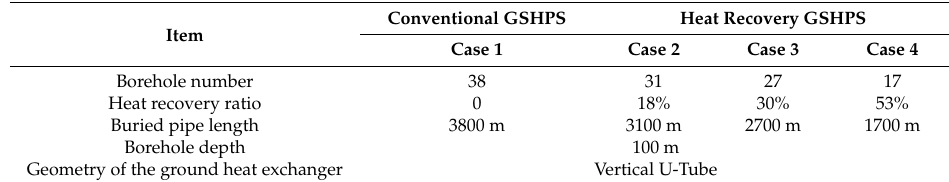
Table 2. Parameters for all scenarios.